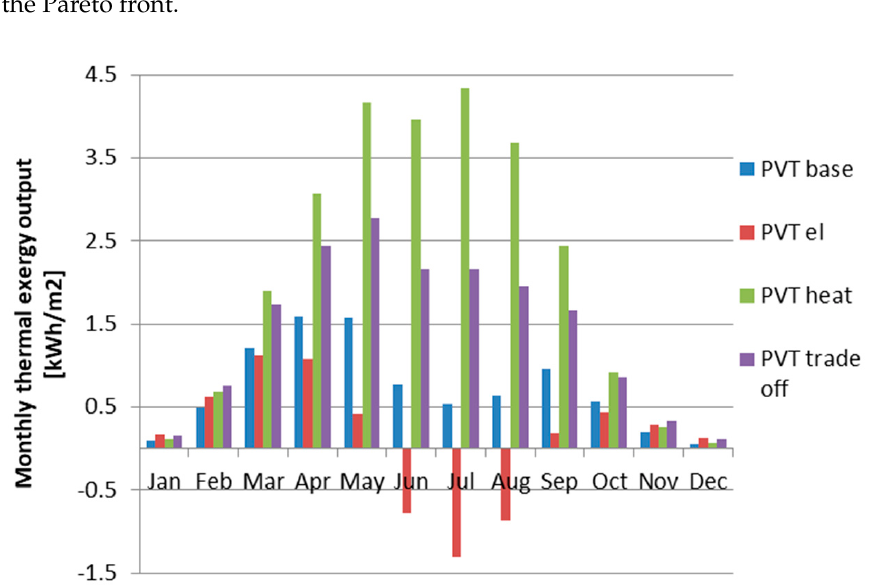
Figure 19. Monthly thermal exergy of different PVT designs.